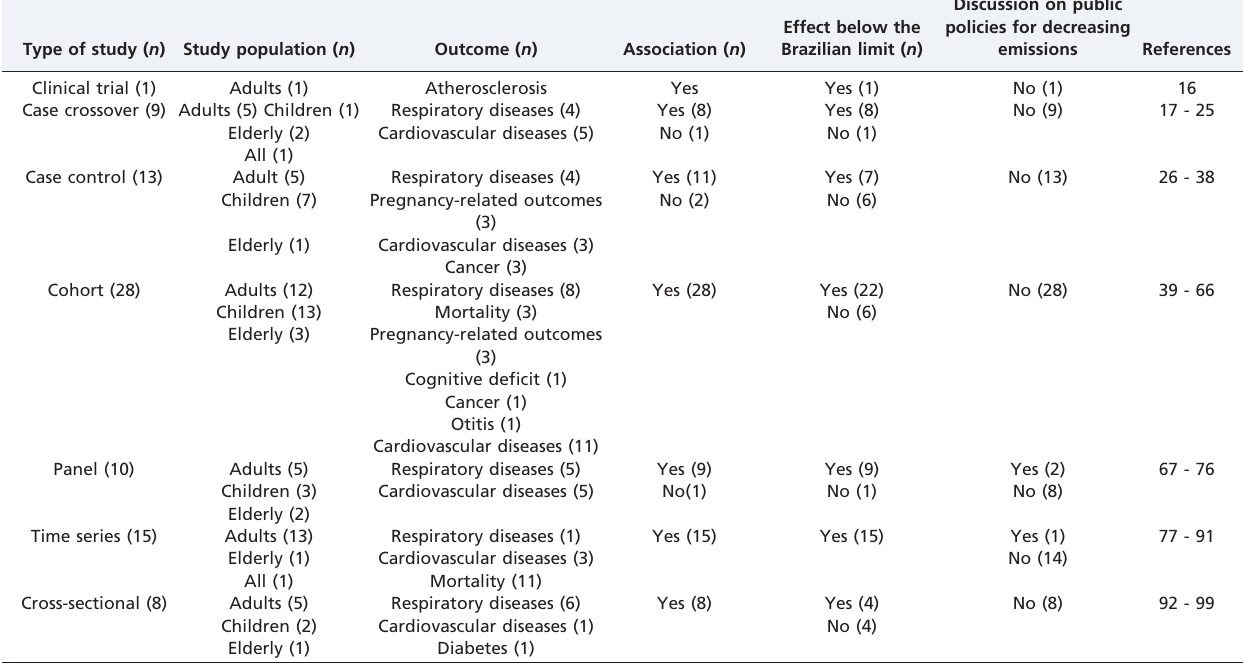
Table 1 - Non-Brazilian studies of air pollution, categorized by type of study, study population, outcomes and effects found.